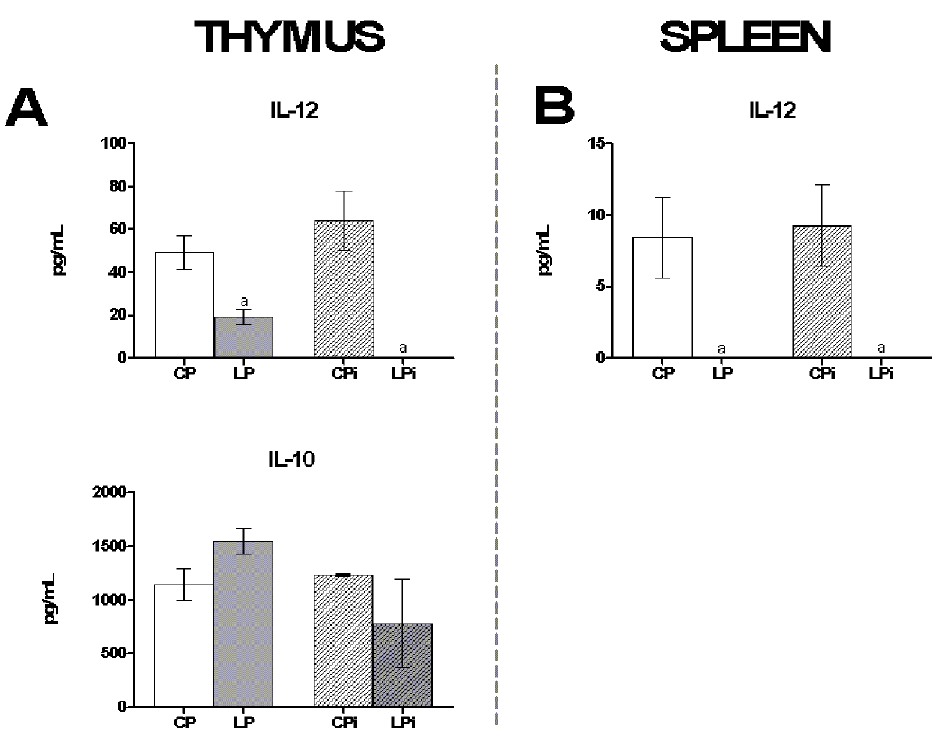
Fig. 8. Protein malnutrition dysregulated secreted cytokine levels in the interstitial fluid of thymus and spleen of mice infected with L. infantum . IL-10 and IL-12 protein levels were measured by Luminex in the interstitial fluid of ( A ) thymus and ( B ) spleen. The values are expressed in pg/mL ¡ SEM. CP: animals fed 14% protein diet; LP: animals fed 4% protein diet, CPi: animals fed 14% protein diet and infected; LPi: animals fed 4% protein diet and infected. Two-way ANOVA analysis with Bonferroni pos-hoc test. Statistical differences due to diet: a (p , 0.001).